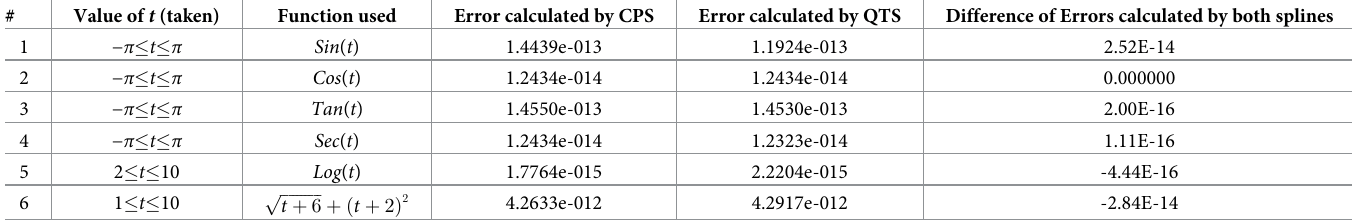
Table 3. Table of error analysis, for CPS and QTS, for a variety of